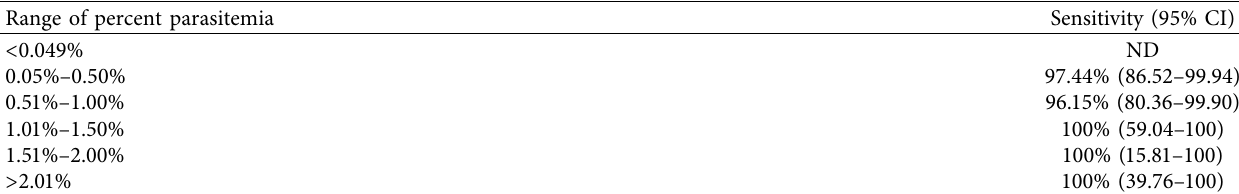
Table 5: Association between the sensitivity of Care Start ™ and percent parasitemia, Arba Minch, 2016. Range of percent parasitemia